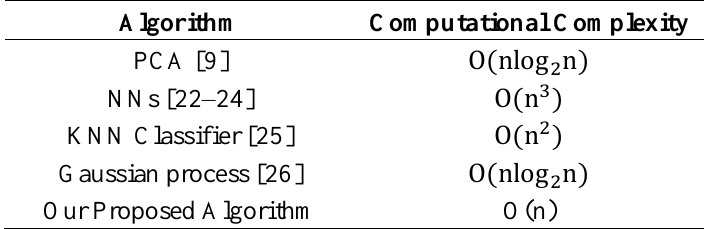
Table 4. Comparison of time complexity with different algorithms.